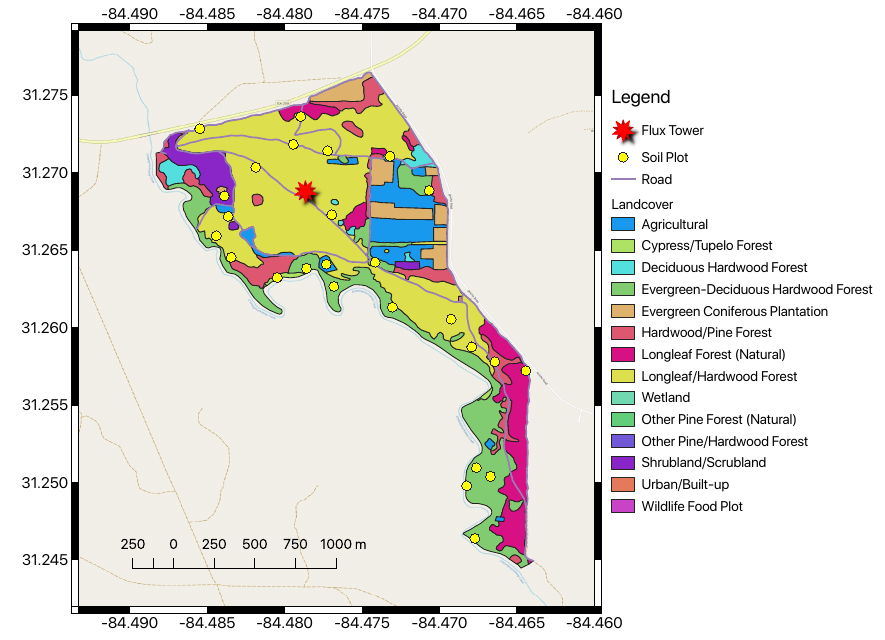
Figure 4. Jones Ecological Research Center (JERC) RD flux tower and landcover classes.